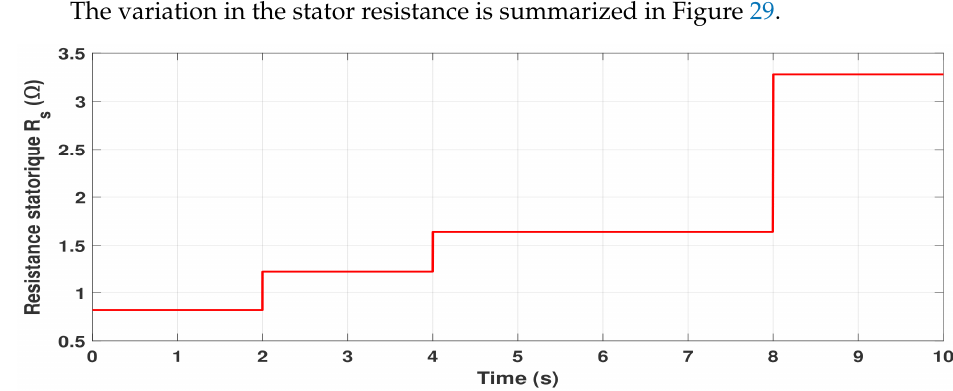
Figure 29. Variations in resistance as a function of time (s).